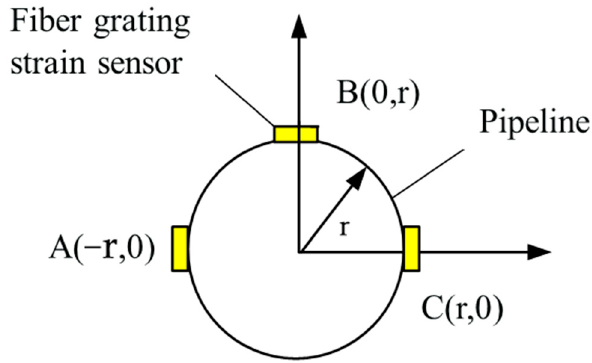
Figure 17. Layout plan of pipeline strain sensor.